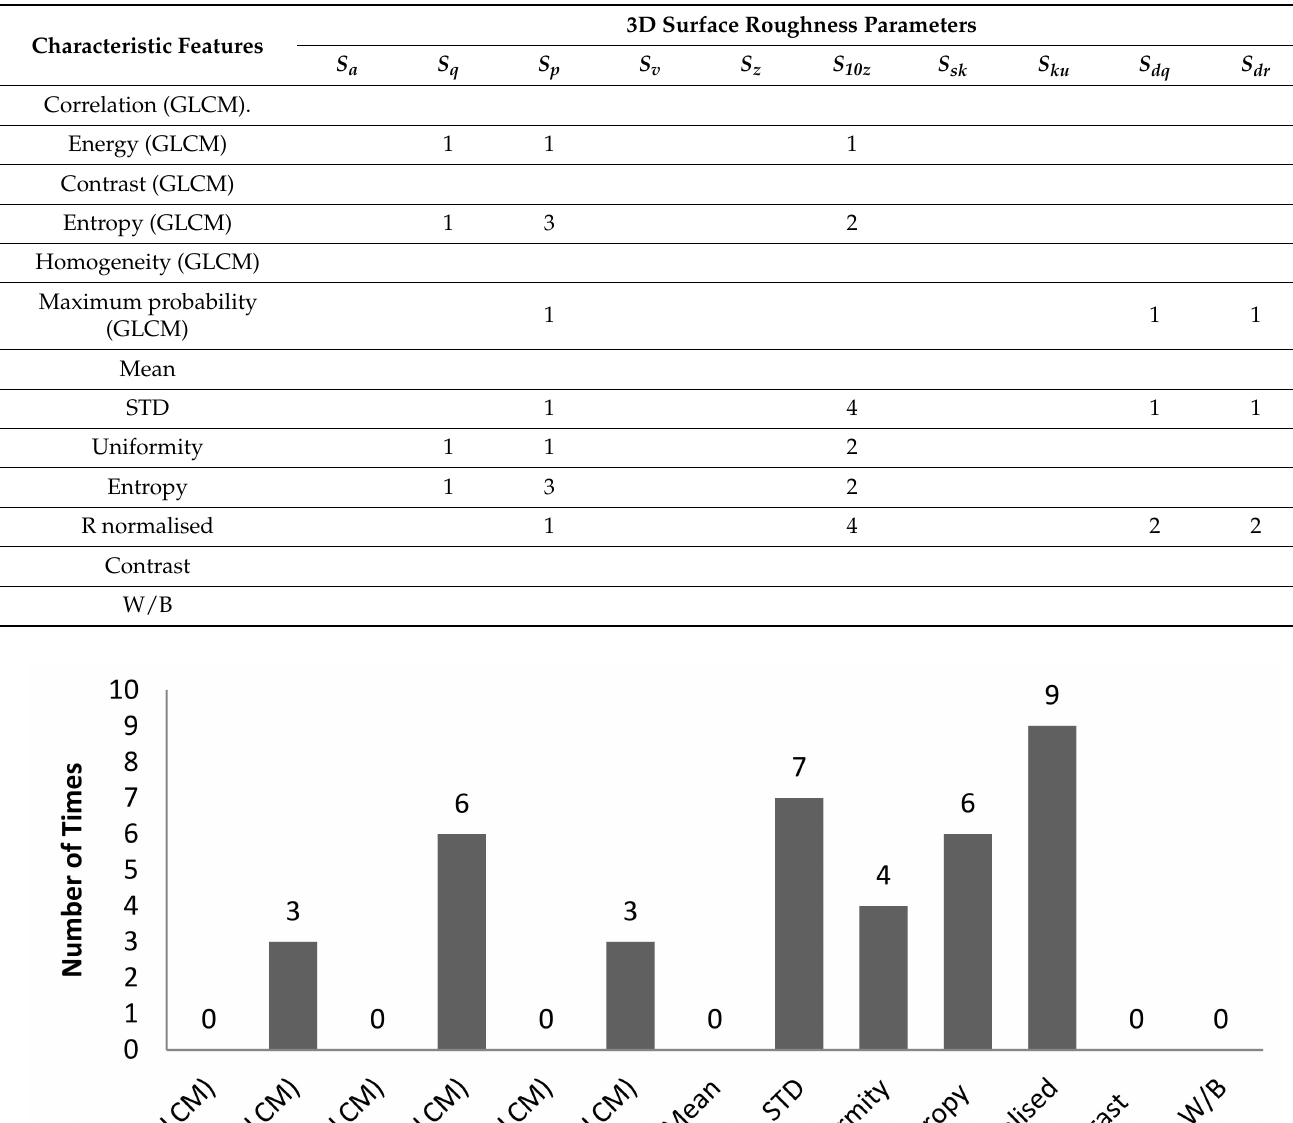
Table 2. Tabulation of the number of times a correlation between characteristic features and 3D